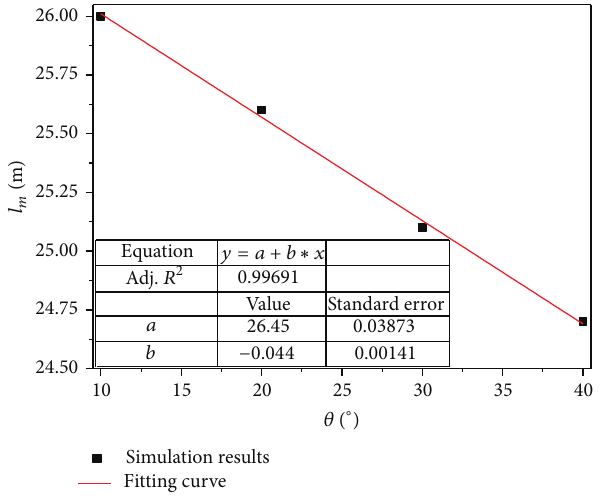
Figure 15: The maximum gas mixture length ( 𝑙 𝑚 ) versus the inclination angle ( 𝜃